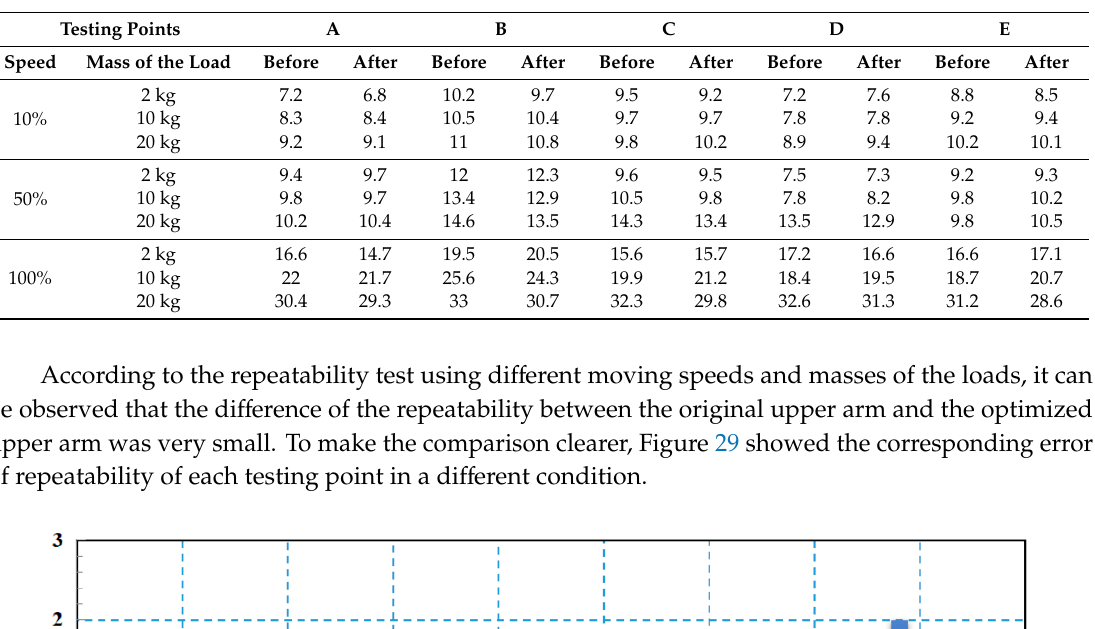
Table 9. Repeatability test records of the upper arm before and after optimizations (Unit: µ m).